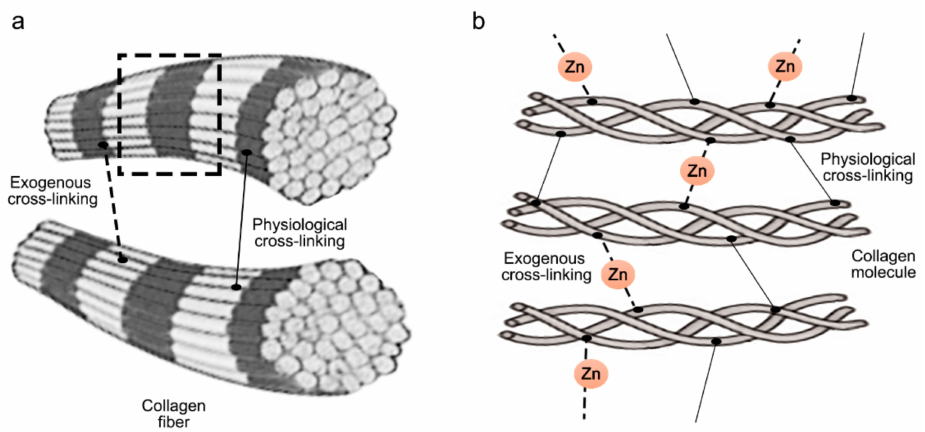
Figure 7. Scheme illustrating exogenous and physiological crosslinking induced as inter and in- tramolecular crosslinks. ( a ) crosslink between collagen fibrils, ( b ) dashed line area observed in a in more detail displaying individual collagen molecules composed of single α chain crosslinked by additional exogenous crosslinks